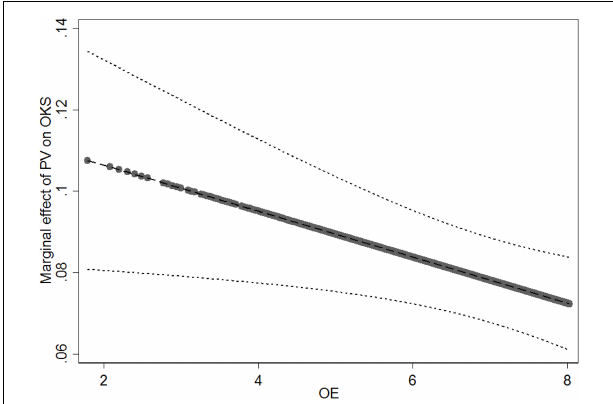
FIGURE 2 | Moderating effect of online expertise (OE) on the relationship between patients’ visit (PV) and online knowledge sharing (OKS).